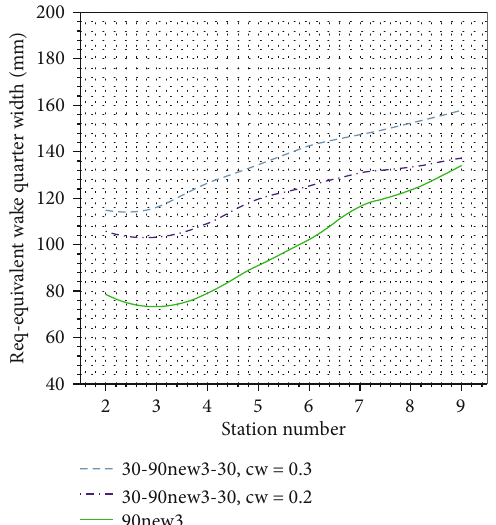
eq variations for 2 triple